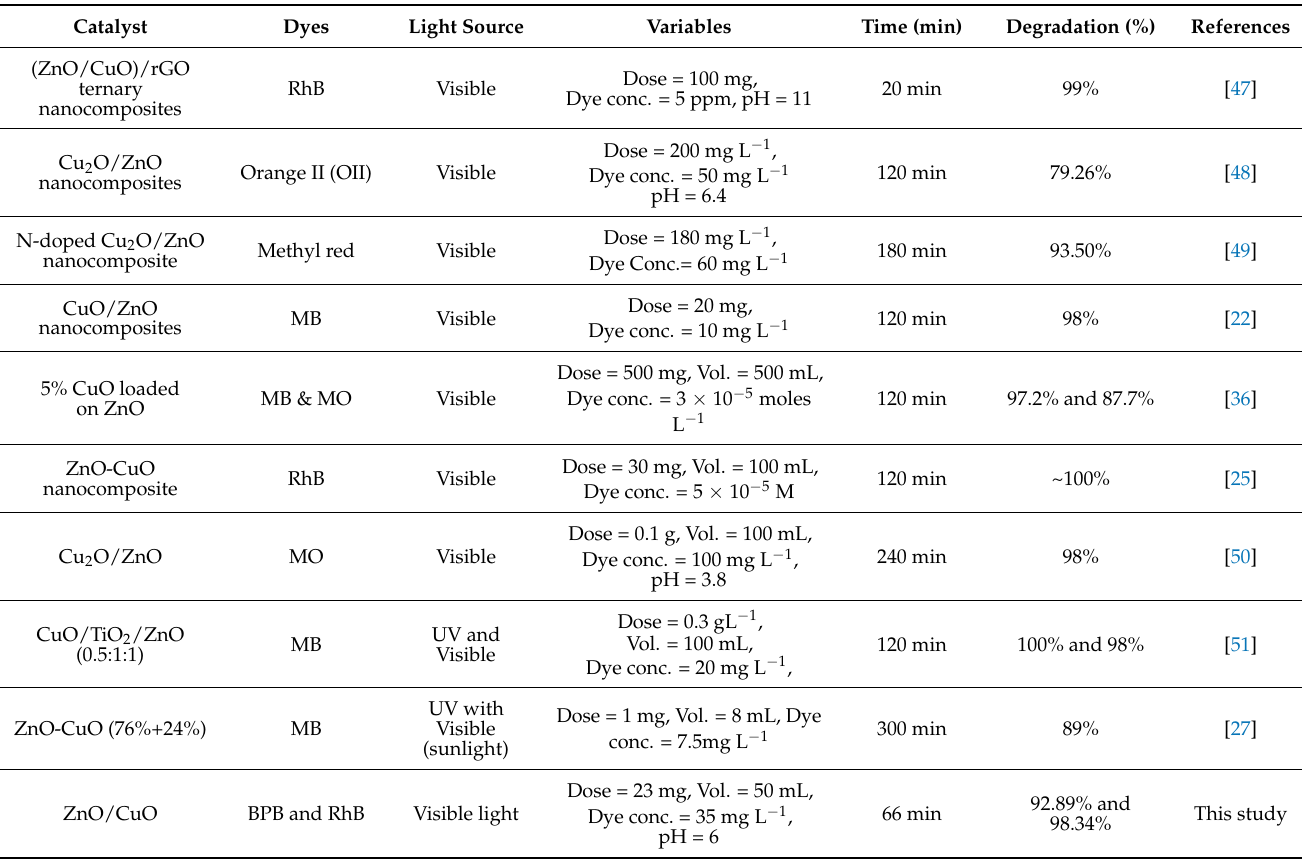
Table 7. Comparison of maximum dye degradation percentages of various